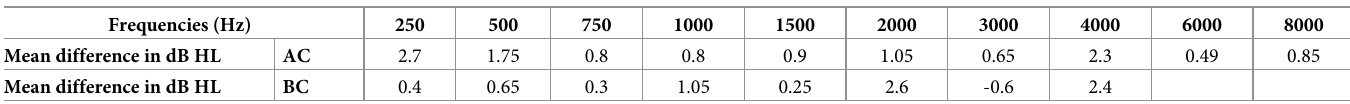
Table 4. Mean difference of air and bone conduction thresholds (dB HL) between gold standard (GS) and HEARZAP (HZ) audiometer. Frequencies